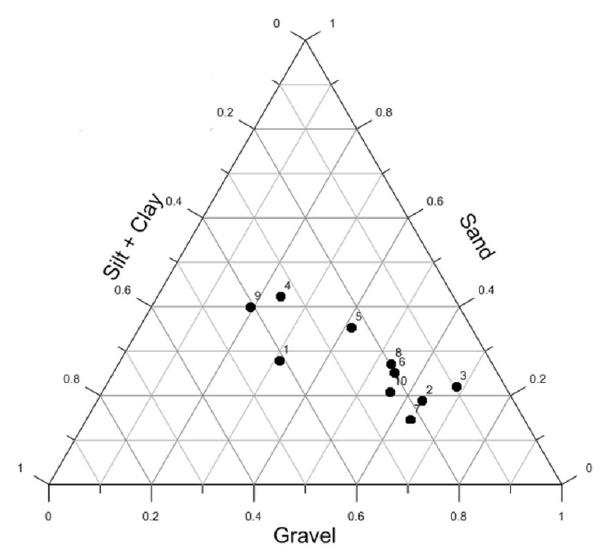
Fig. 8. Ternary plot presenting grain size composition of the sam- ples collected from a borehole located on the road behind the main scarp (marked in red in Fig. 6). Each sample refers to 1.5m thick- ness, from the soil surface (sample no. 1) to 15m depth (sample no.